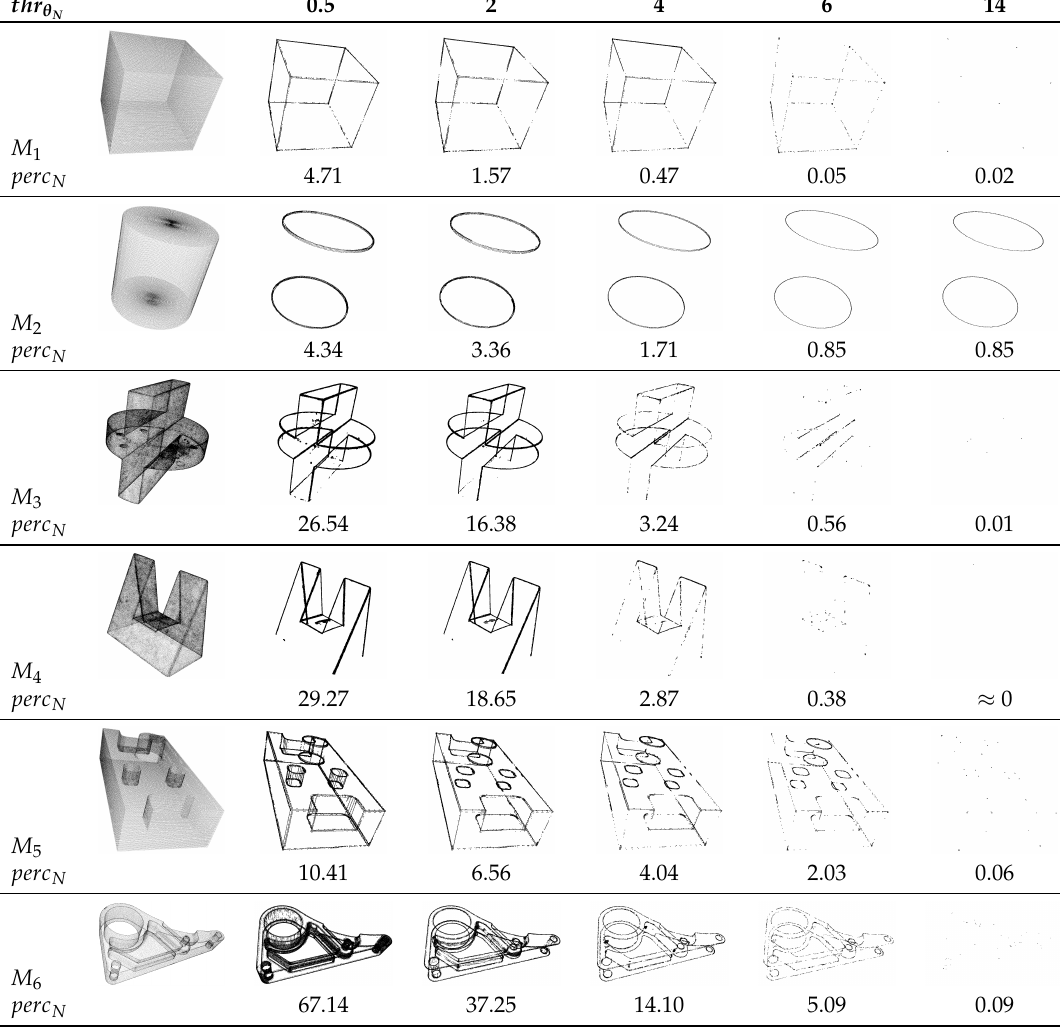
Table A1. Table of thr θ